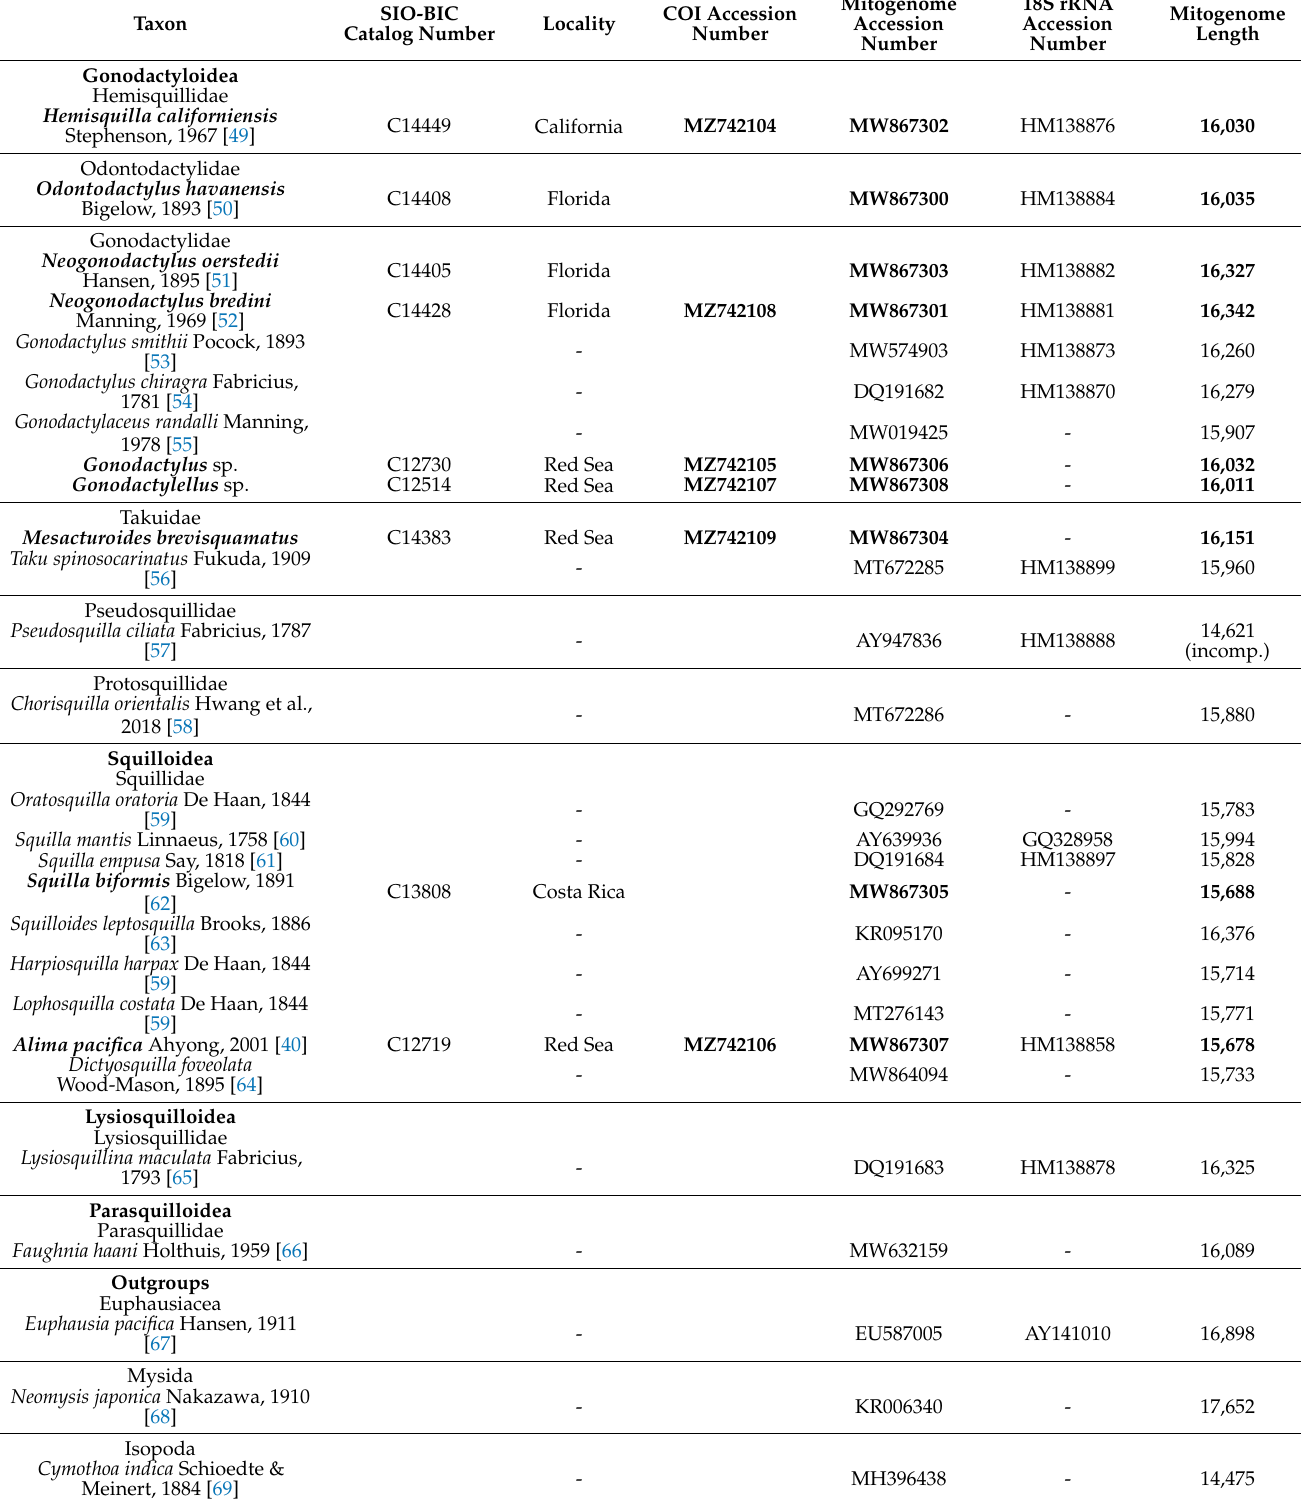
Table 1. Collection information, vouchers, GenBank accession numbers (COI, mitogenome, 18S rRNA), and mitogenome length. New COI sequences and mitogenomes are in